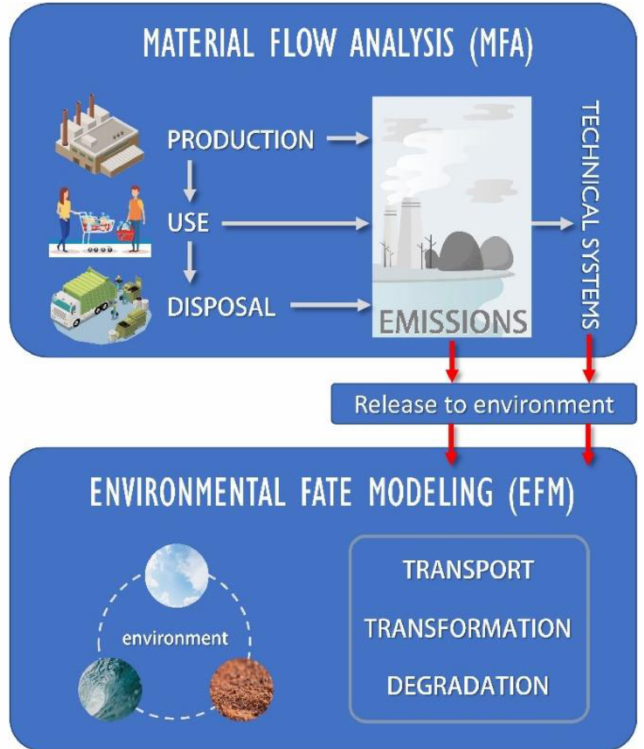
Figure 4. Schematic of how Environmental Fate Models (EFM) models are related to Material Flow Analysis (MFA)